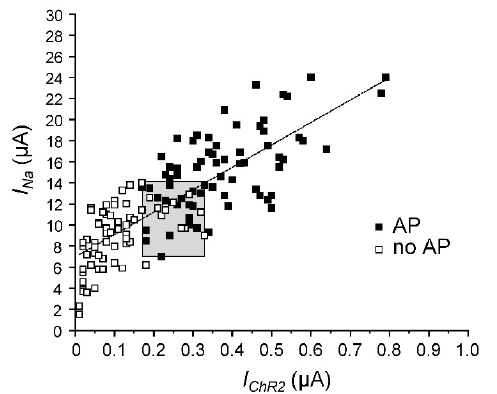
Figure 4. Correlation between peak Na + current ( I Na ) and light-induced photocurrent ( I ChR2 ) obtained for Na v 1.5-CC-2. Each data point represents both current measurements from a single oocyte. We used a total of 131 oocytes from 6 different batches. Subthreshold depolarizations were obtained in 63 oocytes (open squares). APs were recorded in 68 oocytes (filled squares). Although we tried to keep constant conditions for cRNA injection and current measurement, a considerable variation in channel expression was noticed among these 6 batches of oocytes. Nonetheless, the linear fit indicates that the I Na : I ChR2 ratio was relatively constant (y = 21.25x + 6.97; R 2 = 0.63). The gray box illustrates the threshold conditions, defined by the smallest I Na or I ChR2 that was still sufficient for AP generation, and by the largest I Na or I ChR2 that produced only subthreshold depolarization. The corresponding range was between 7 to 14 μ A for I Na , and 170 to 330 nA for I ChR2 . The straight line does not run through the zero point of the diagram, indicating an underestimation of I ChR2 . This was most likely due to technical limitations to deliver the blue ‐ light pulse to the whole oocyte surface.